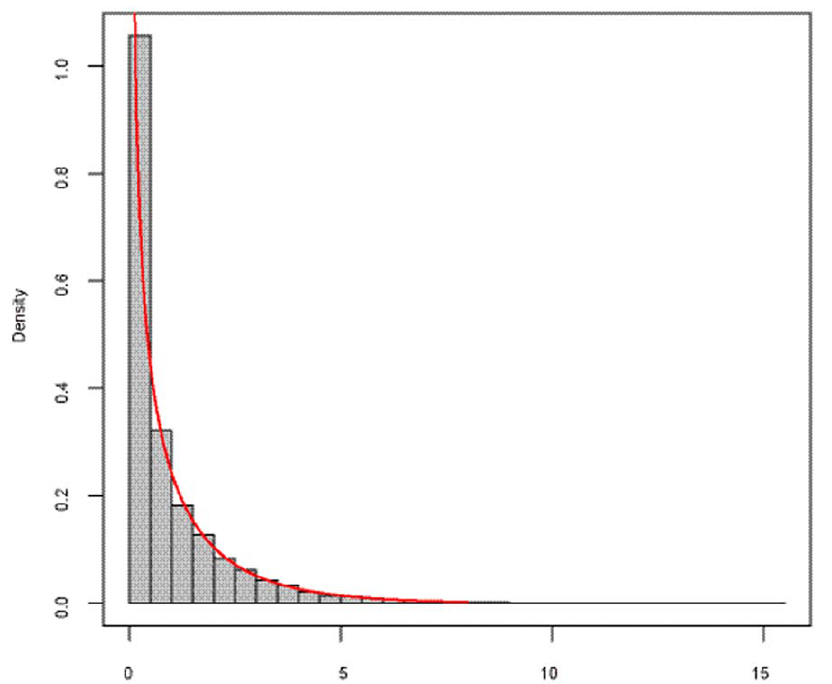
Figure 3. Frequency histogram of the LD based statistic based on 10,000 simulations, compared with x 2 (1). The gray bar denotes the frequency histogram of the LD based statistic, corresponding to the null hypothesis that two SNPs are of no interaction. The red line is the density curve of the theoretical one.